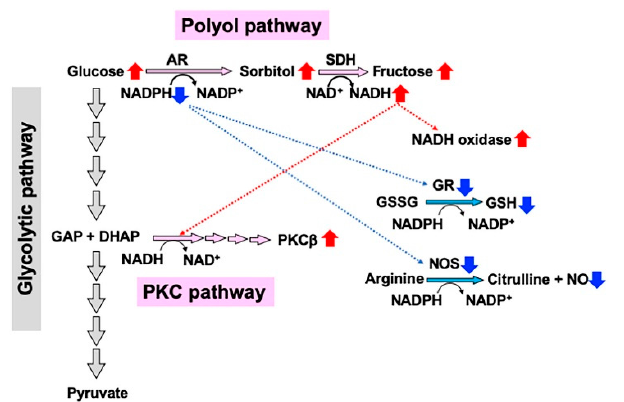
Figure 2. Redox state changes induced by the polyol pathway hyperactivity under high glucose conditions. Nicotinomide adenoside dinucleotide phosphate (NADPH) consumption during the first step catalyzed by aldose reductase (AR) suppresses the activities of glutathione reductase (GR) and nitric oxide synthase (NOS), which leads to the reduction in glutathione (GSH) and NO, respectively. NADH upregulation during the second step catalyzed by SDH increases the activities of NADH oxidase and PKC β . GAP: glyceraldehyde 3-phosphate, DHAP: dihydroxyacetone phosphate. Red and blue arrows indicate increases and decreases in the amount or activity of molecules, respectively.